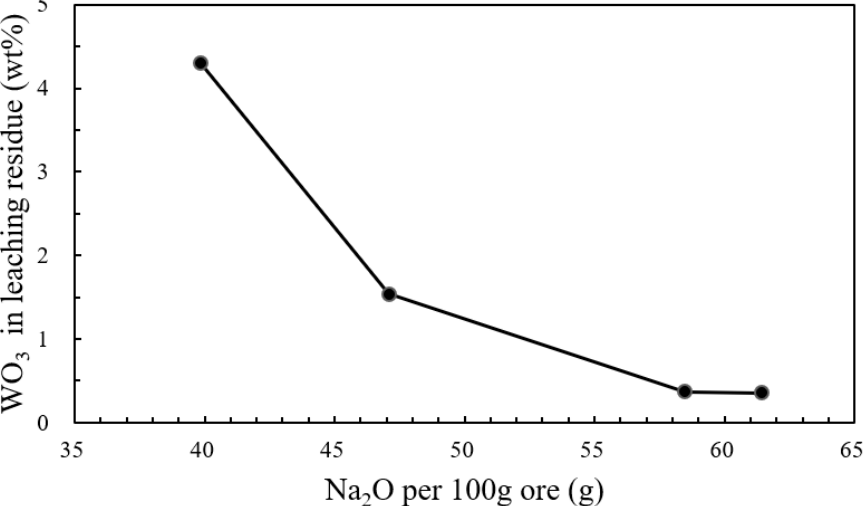
Figure 4. Effect of Na 2 O on WO 3 content in leaching residue at 1200 °C in air with 30% SiO 2 .